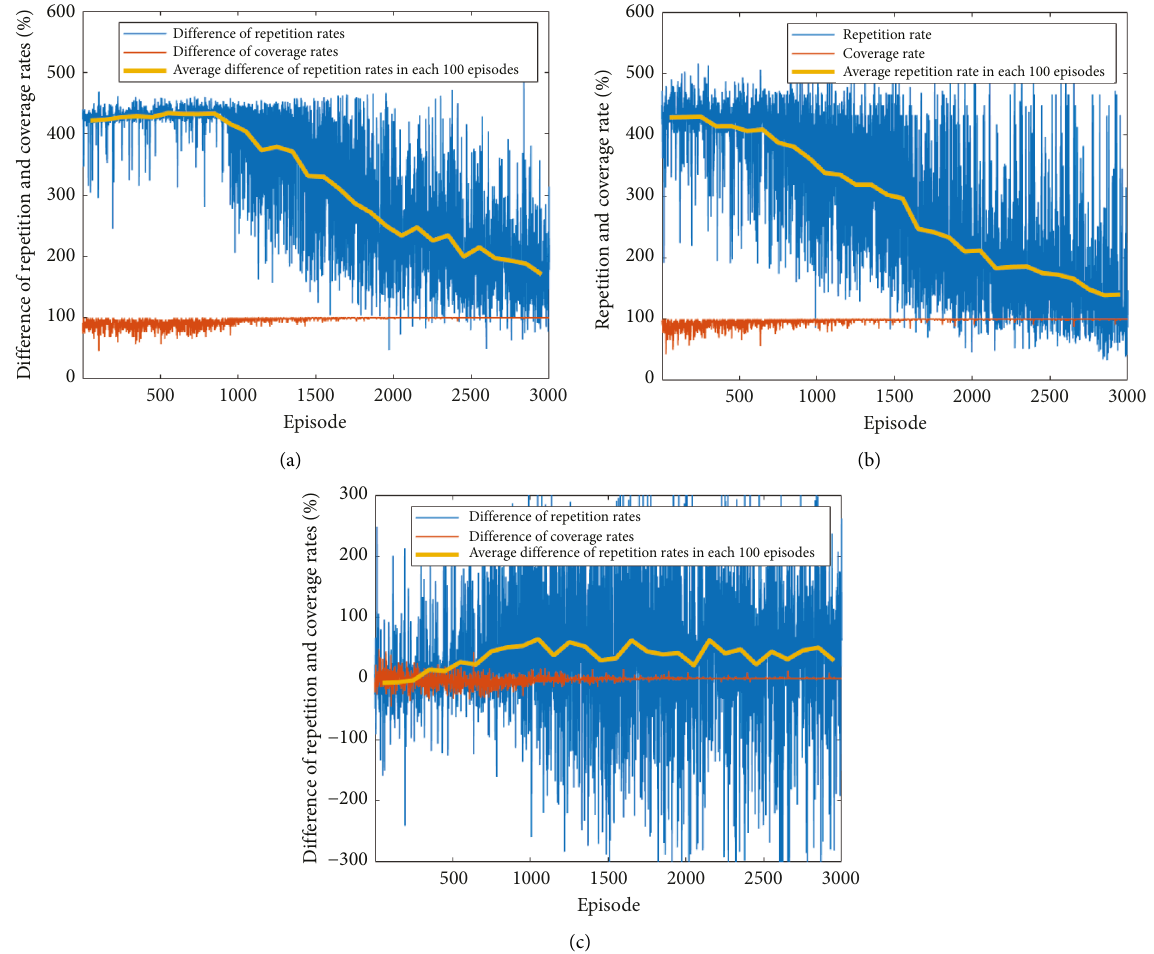
Figure 5: Control experiment of state representation. (a) State input as the matrix. (b) State input as three-channel encoding. (c) Difference between these two methods (data from (a) minus the data from (b)).